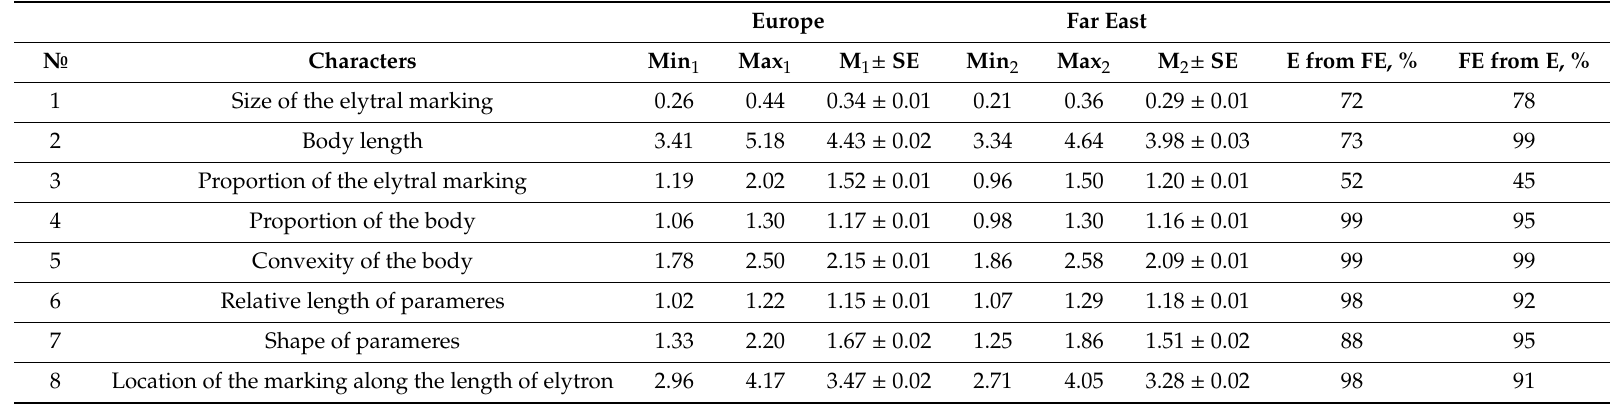
Table 2. Metric characters of the populations from Europe and the Far East. M—mean value, σ —standard deviations, SE—standard error. Numbers of characters correspond to their numbers in the text. E from FE—ratio of specimens from Europe within the range of variability of the samples from the Far East, FE from E—ratio of specimens from the Far East within the range of variability of the samples from